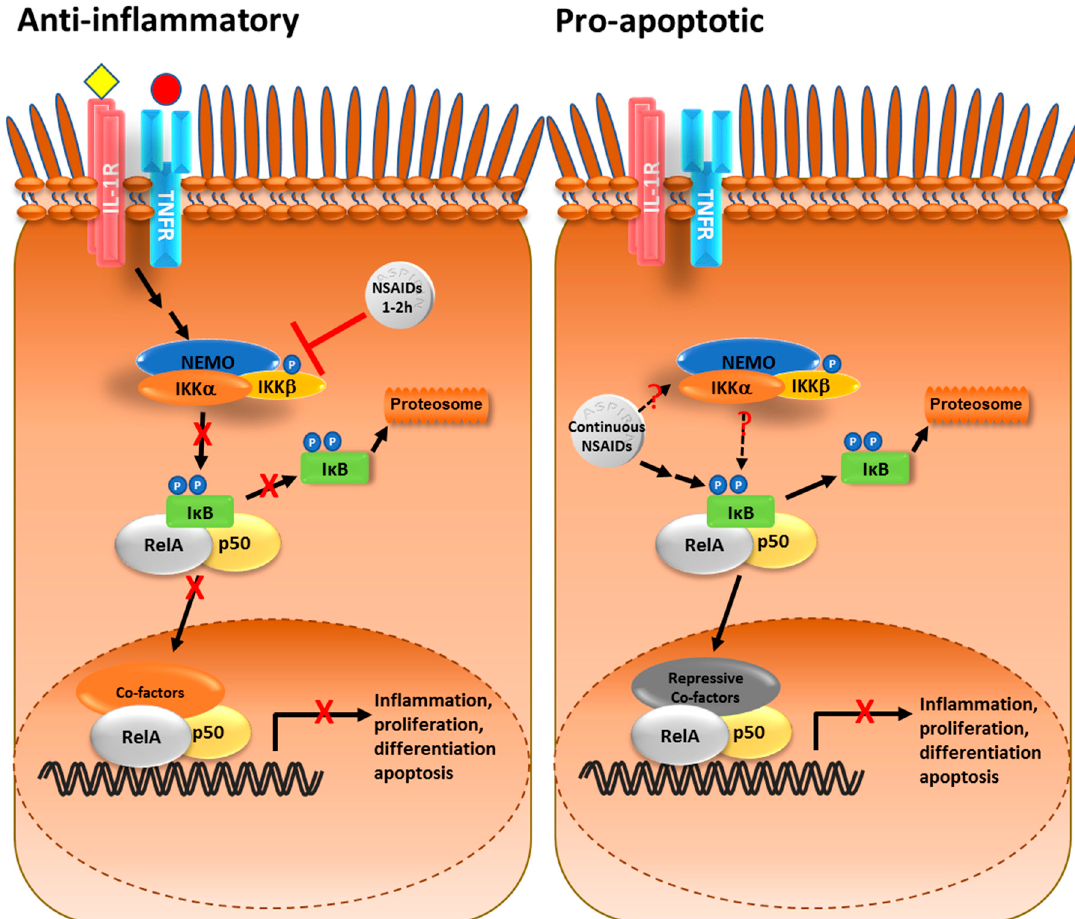
Figure 1. Aspirin modulation of the nuclear factor-kappaB (NF- κ B) pathway. ( Left ) The NF- κ B transcription factor, most commonly a hetero-dimer of the RelA (p65) and p50 polypeptides, is held in the cytoplasm by the inhibitory protein I κ B. When the cell is stimulated by growth factors or cytokines (e.g., interleukin-1 (IL-1) or tumour necrosis factor (TNF)), I κ B is phosphorylated by the I κ B kinase (IKK) complex, which targets it for degradation by the proteasome. This allows NF- κ B to translocate to the nucleus and regulate expression of target genes. In cancer cells, NF- κ B is constitutively active which drives tumour progression. Short pre-treatment with aspirin or related non-steroidal anti-inflammatory drugs (NSAIDs) blocks cytokine-mediated activation of the pathway by inhibiting the IKK complex, particularly IKK β ; T bar: NSAIDs inhibit IKK kinase activity. IL-1R: IL-1 receptor; TNFR: TNF receptor; NEMO (IKK γ ); ( Right ) In contrast, prolonged exposure to NSAIDs in the absence of additional NF- κ B activators stimulates degradation of I κ B and nuclear translocation of NF- κ B. This NF- κ B recruits specific complexes which lead to repression of NF- κ B-driven transcription and the induction of apoptosis. Dotted lines: It remains unclear whether the IKK complex plays a role in the stimulatory pathway or whether NSAIDs target I κ B by another